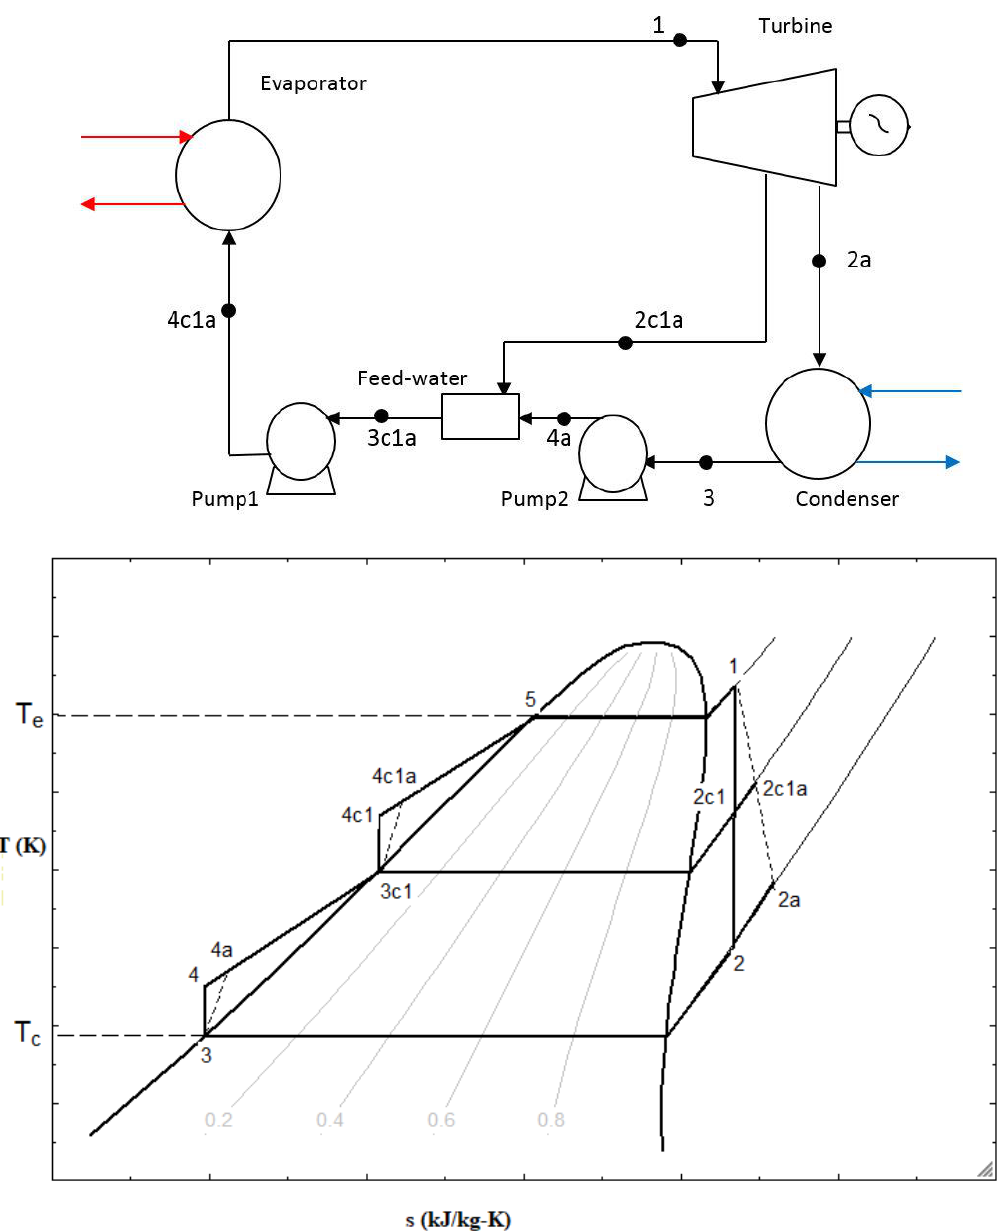
Figure 2. Schematic diagram of the cycle and T-S thermodynamic diagram of the regeneration ORC (RORC) system.